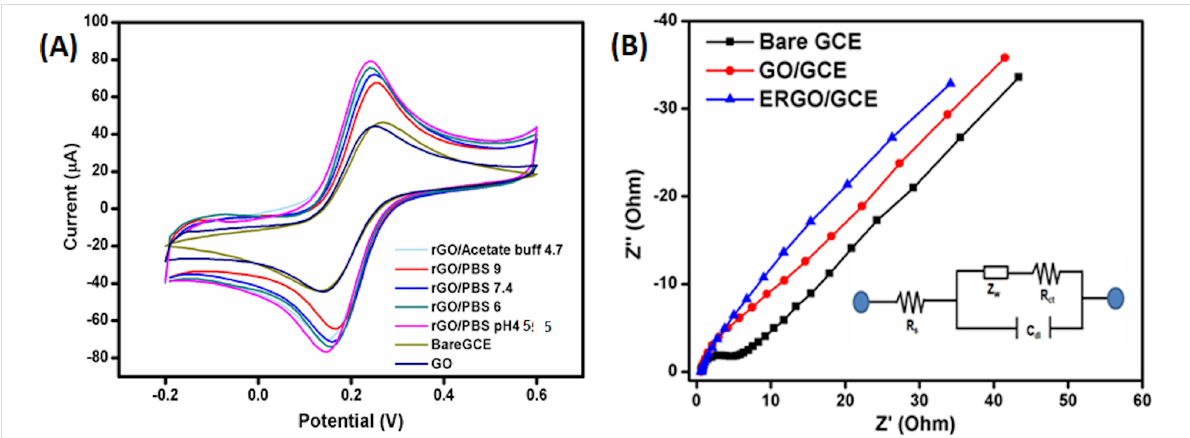
Figure 4: (A) Cyclic voltammograms of GO and ERGO using different electrolytic buffers: Acetate buffer pH 4.7, PBS pH 4.6, PBS pH 6, PBS pH 7.4, PBS pH 9. (B) Nyquist plot of bare GCE, GO/GCE, and ERGO/GCE in the presence of 1 mM [Fe(CN) 6 ] 4 − /3 − containing 0.1 M KCl.